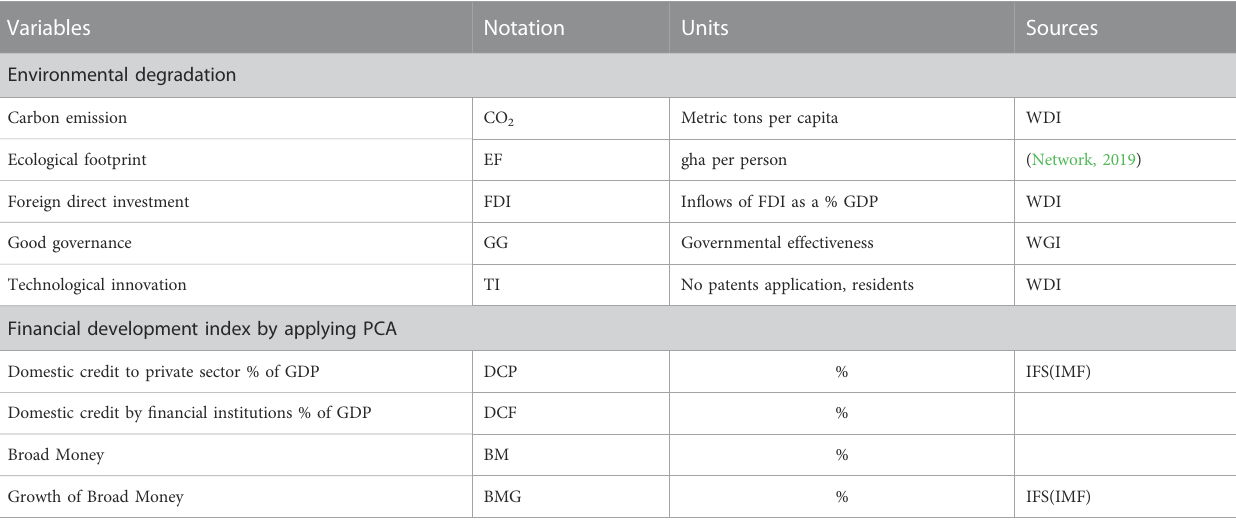
Hypothesis-4: Ethnological innovation fosters the process of environmental development.